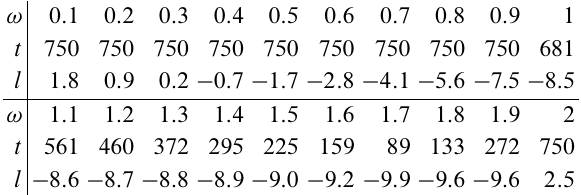
Table 1. SOR: numbers of iterations for tested ! .